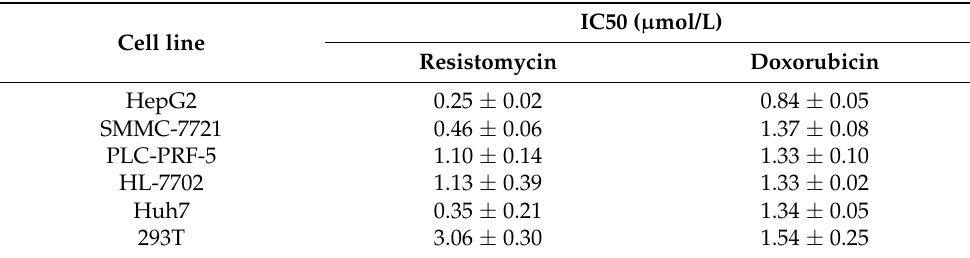
Table 1. The IC50 values for resistomycin cytotoxicity after 48 h on human liver cancer cell lines and normal cell